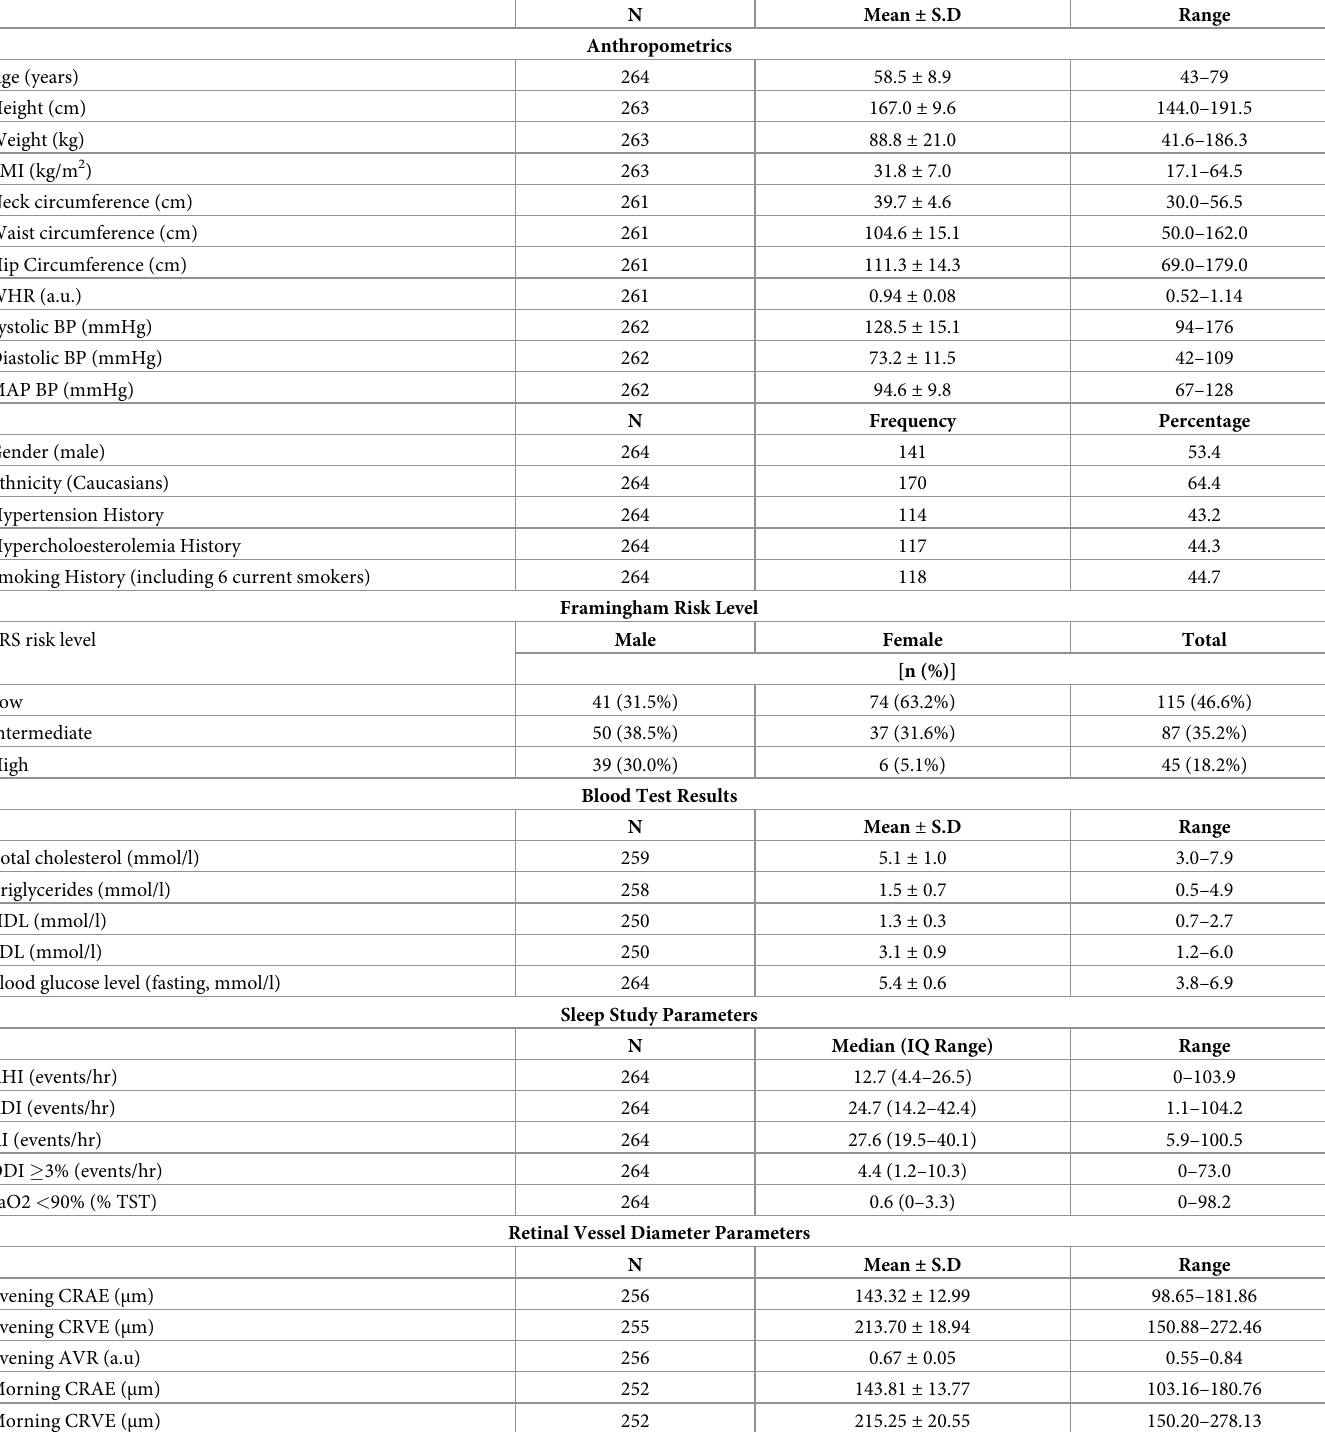
Table 1. Main group demographics and sleep disordered breathing status. Demographics and SDB status of the Main Group at baseline, presented as mean ± SD, median (IQR) frequency, or n (%), where appropriate, plus